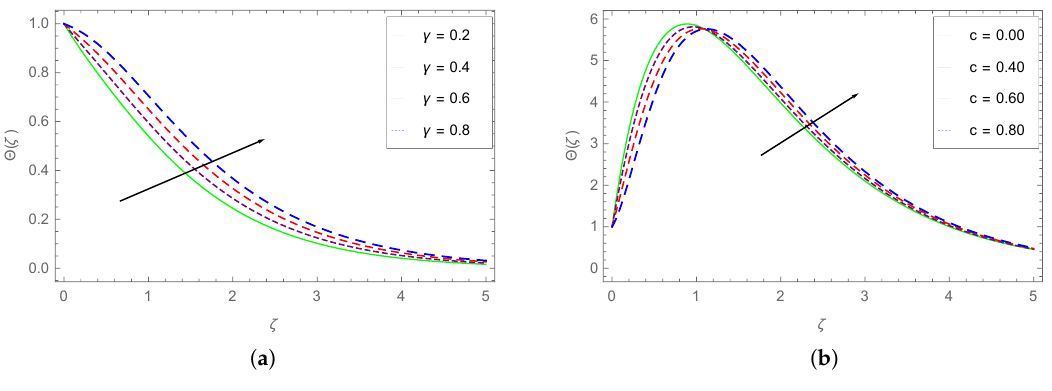
Figure 14. Dependence of θ ( ζ ) on ( a ) γ and ( b ) c